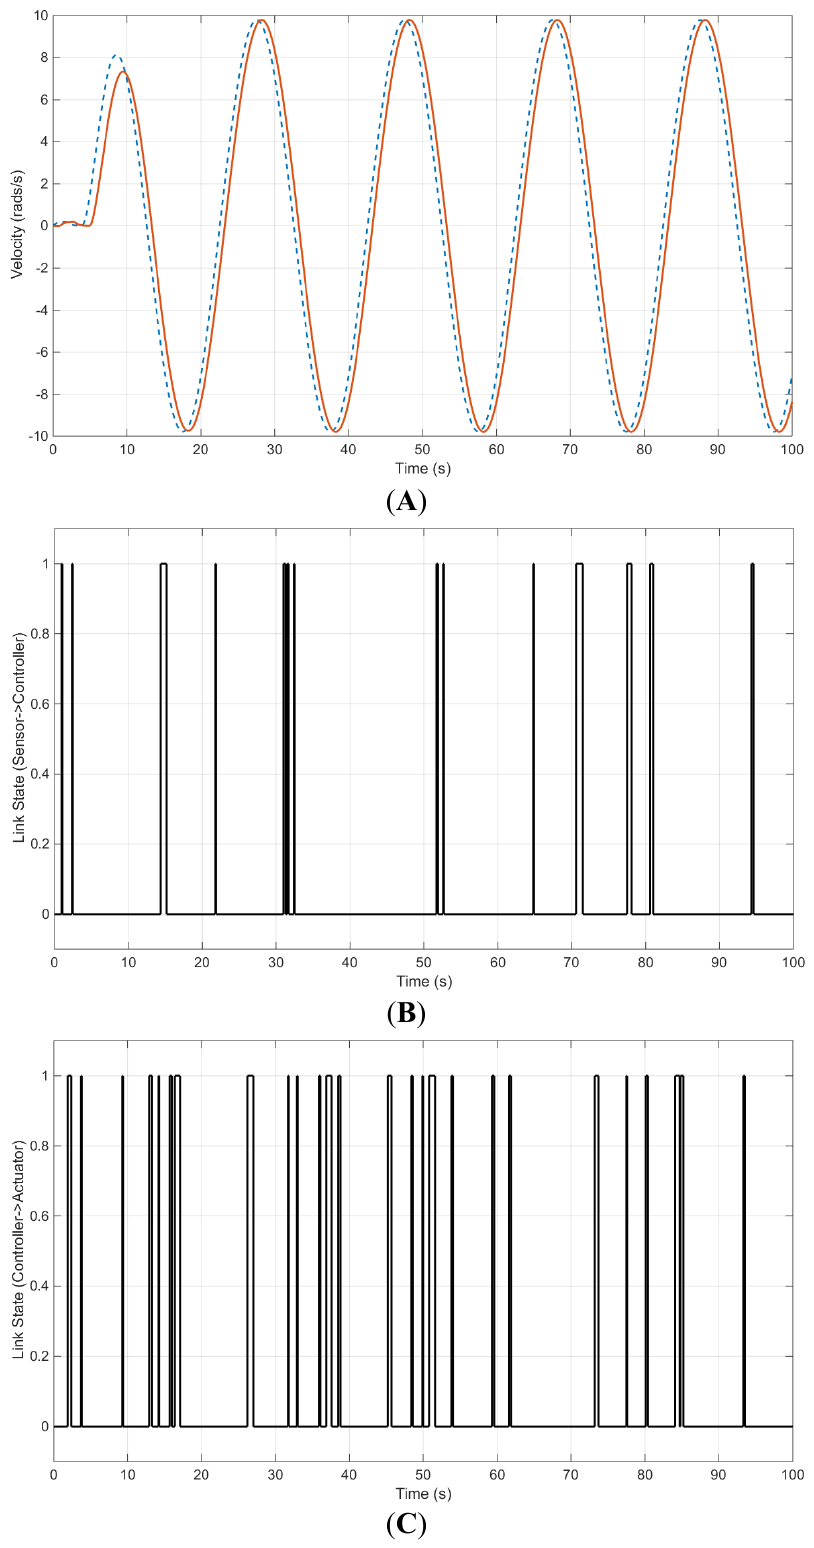
Figure 5. ( A ) effects of burst errors with RC (solid) vs. PC Method (dashed); ( B ): sensor-controller node link state; ( C ): controller-actuator node link